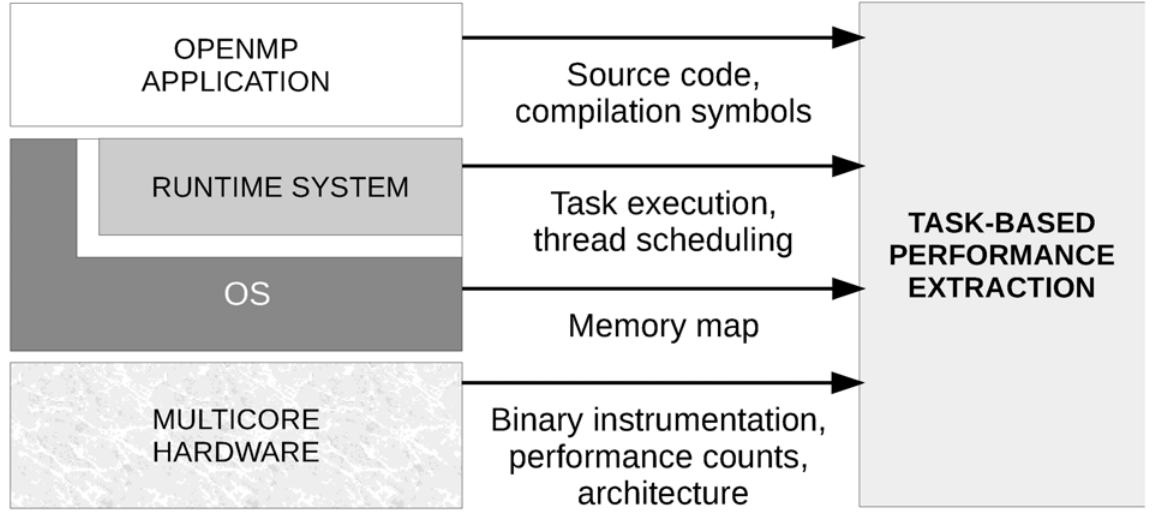
Fig 3. Extraction of task-based performance from OpenMP